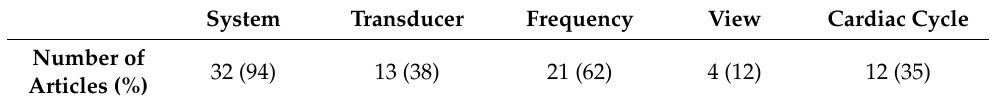
Table 1. Number of articles that stated the ultrasound system and settings.